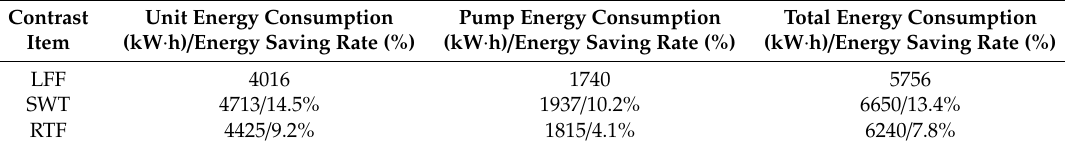
Table 4. Comparison of energy-saving rates of LFF control strategies compared to the other two control